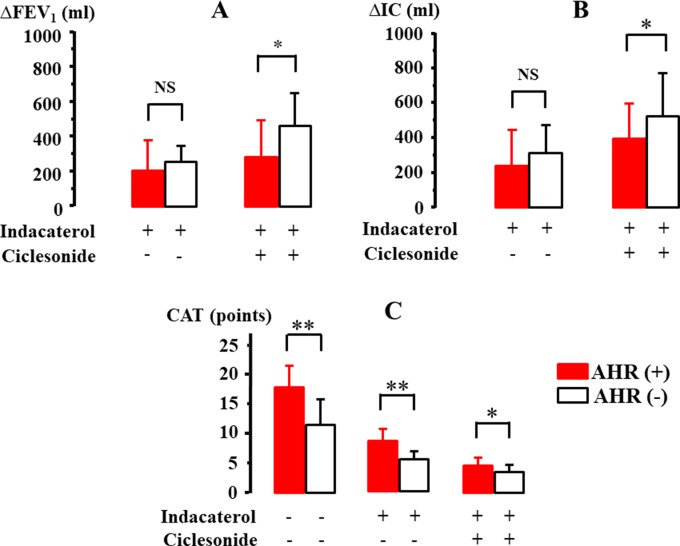
Involvement of airway hyperresponsiveness in the effect of indacaterol and cicleronide on FEV1(A), IC (B), and CAT score (C) in COPD with airway eosinophilia. IC, inspiratory capacity; CAT, COPD assessment test. *P < 0.05, **P < 0.01.